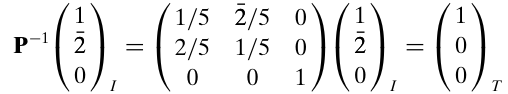
Table 2 Analysis of the eigensymmetry of U U G